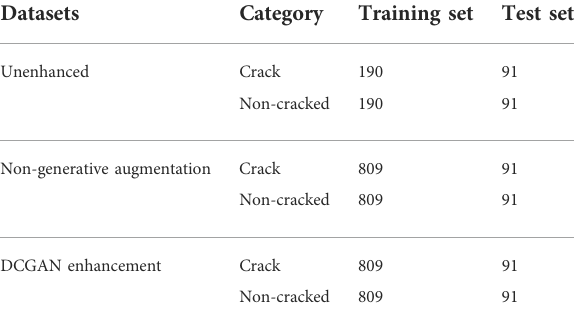
TABLE 2 Distribution of fl uorescent penetrant detection